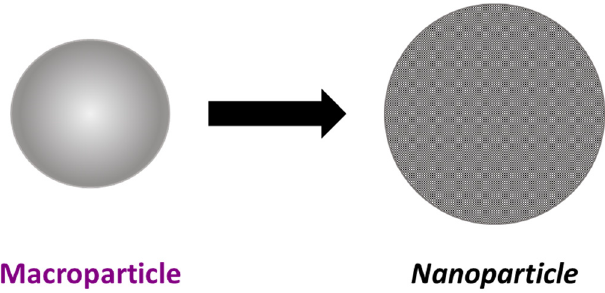
Figure 7. Comparison of macroparticle and nanoparticle surface area to volume ratios.